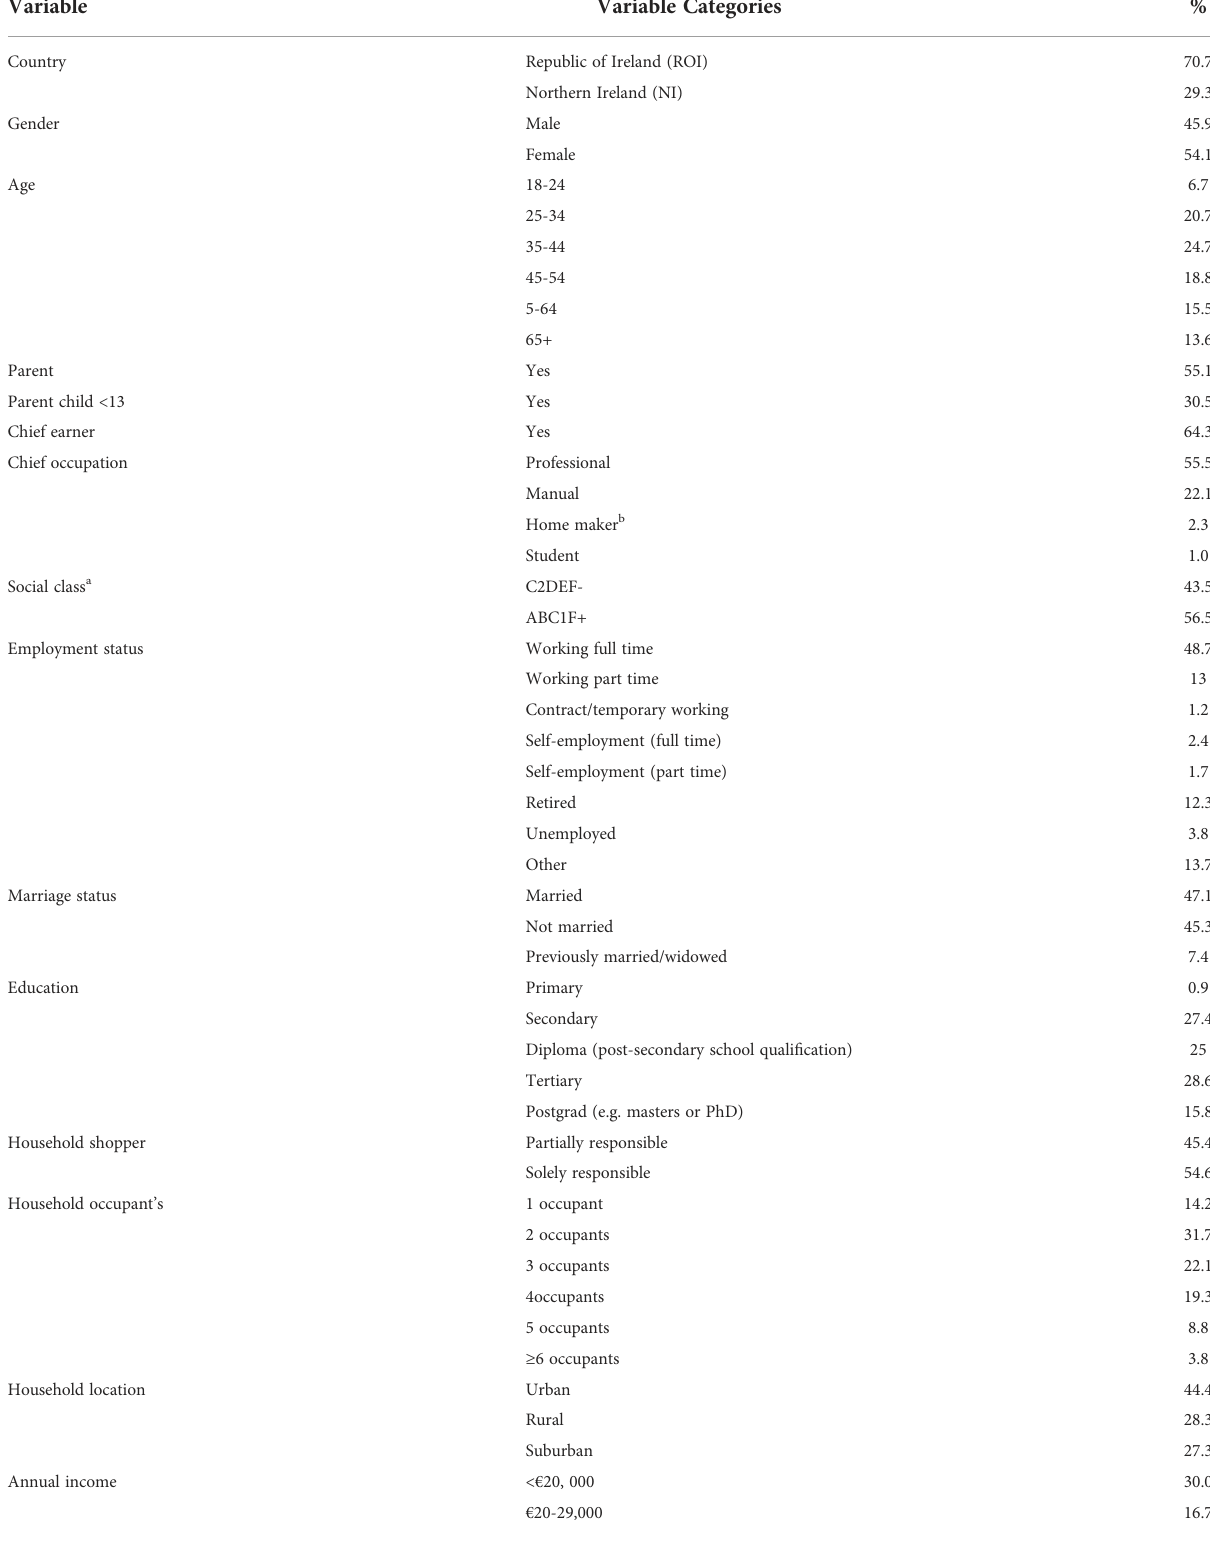
TABLE 1 Pro fi le of the 972 respondents who took part in the study.